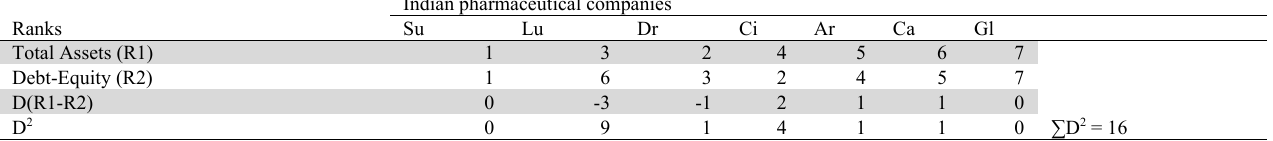
Originating Source: R1 and R2 from table 1 and